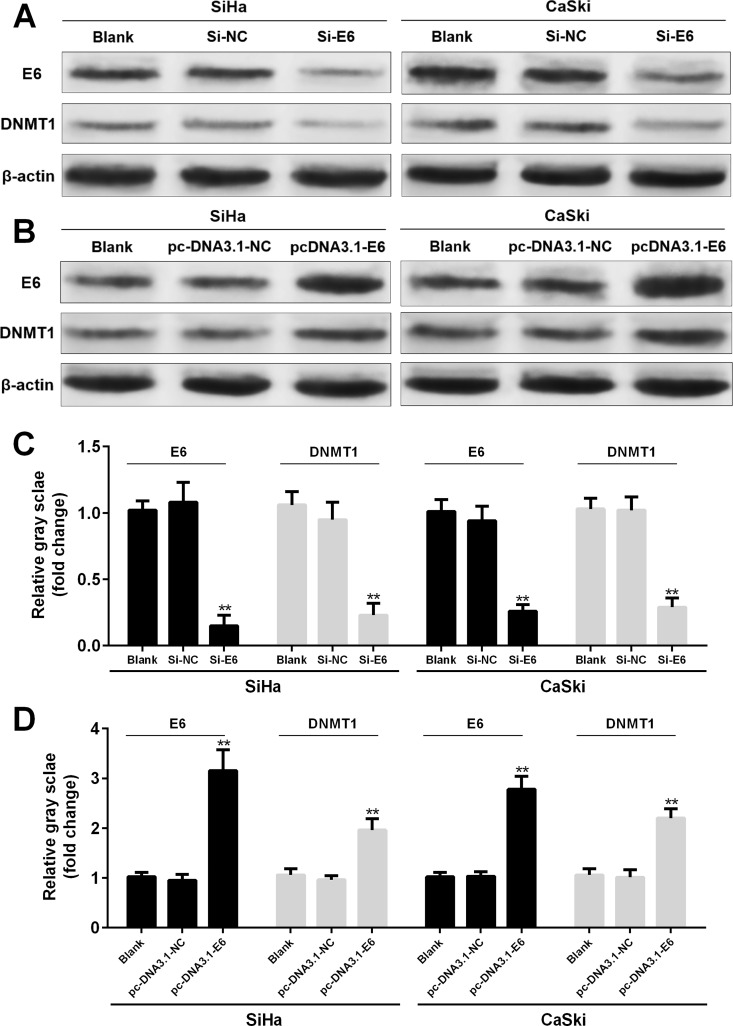
HPV-16 E6 enhances DNMT1 expression in cervical cancer cells.A-B. Images of western blot analysis of HPV-16 E6 and DNMT1 expression in SiHa and CaSki cells after transfection of HPV-16 E6 siRNA (A) or transfected with pcDNA3.1-E6 expression vector (B). C-D. Quantitation of the relative gray scale of protein bands showed in figure A-B. **p<0.01.